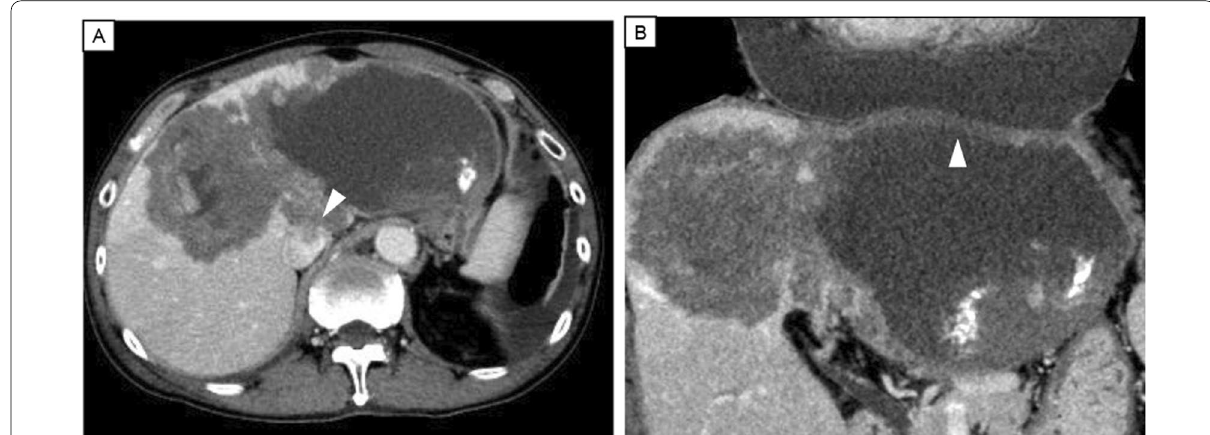
Fig. 2 A CT showed a hepatic lesion with calcification. White arrow head: the echinococcal invasion of the IVC. B Hepatic lesion and pericardial fluid. White arrow head: echinococcal invasion of the pericardium